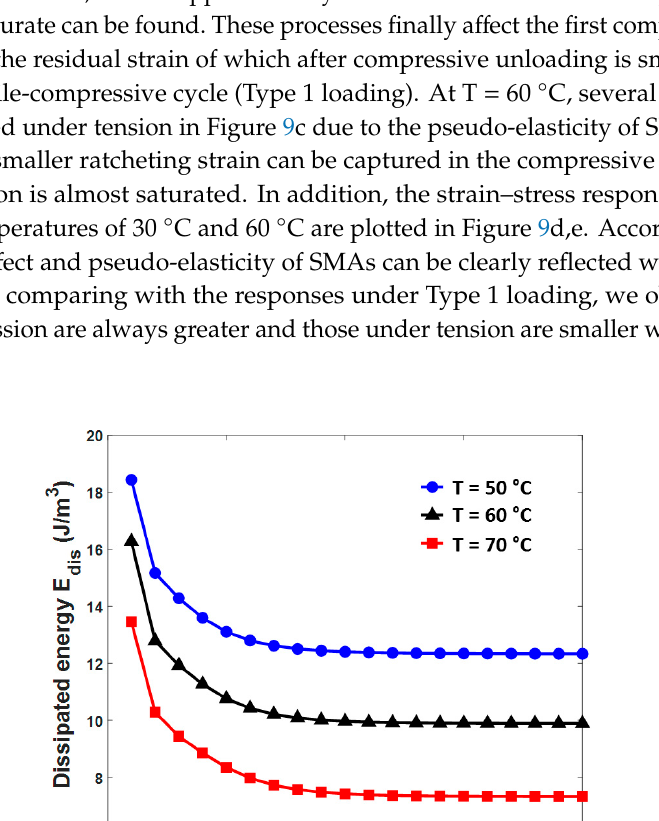
Figure 7. Variations in the dissipated energy dis E during tensile-compressive cycling under different temperatures, i.e., T = 50 ° C, T = 60 ° C, and T = 70 ° C. temperatures, i.e., T = 50 ◦ C, T = 60 ◦ C, and T = 70 ◦ C.